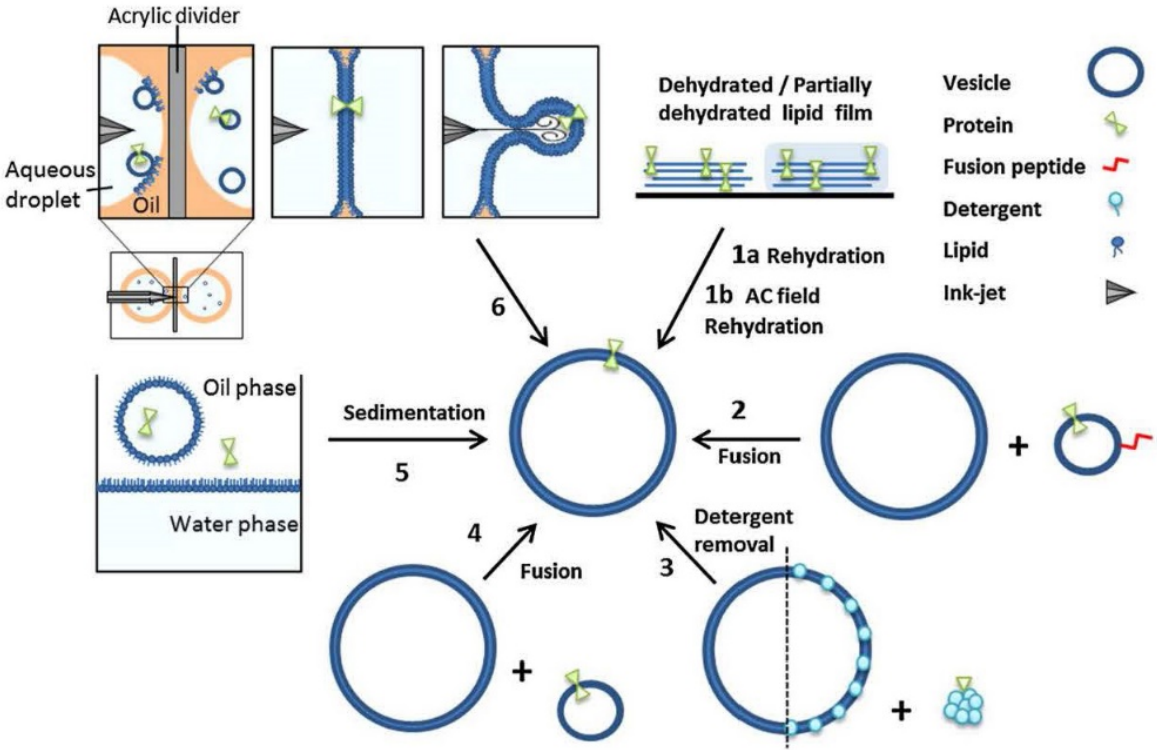
Figure 39. Membrane protein reconstitution in GUVs. Schematic representation of the methods currently used for the preparation of GUVs containing membrane-embedded proteins (“proteo GUVs”), as summarized by Jørgensen et al. (2017) [523]. Some of the methods sketched are related to the methods summarized in Figure 17b for the preparation of membrane protein-free GUVs (drawing is not to scale). (1a) Spontaneous swelling and (1b) electroformation: Rehydration of dehydrated or partially hydrated biological membranes, use of pre-formed “proteoliposomes” or lipid/protein solutions without (1a) or with (1b) applying an external alternating electric field. (2) Vesicle fusion between a preformed GUV and “proteoliposomes” containing membrane fusion-inducing peptides. (3) Addition of a lipid/detergent/protein complex to preformed GUVs. (4) Spontaneous fusion of “proteoliposomes” with preformed GUVs. (5) Application of the “droplet- transfer method” with the membrane protein being dissolved in the aqueous interior volume of the initial w/o-droplets or dissolved in the “oil”. (6) Application of the “microfluidic jetting method” involving the use of “proteoliposomes”. See [523] for details. Reproduced with permission from [523], Springer Nature, 2017.